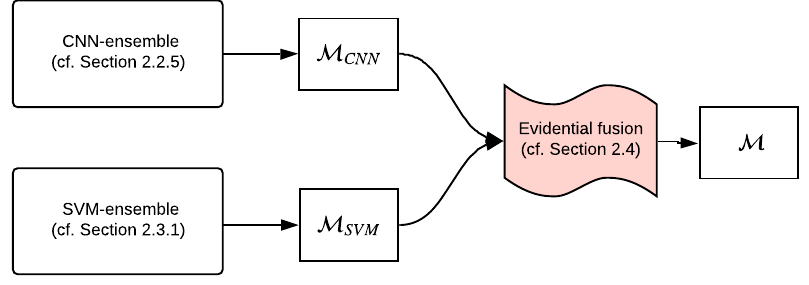
Figure 1. Proposed evidential MCS